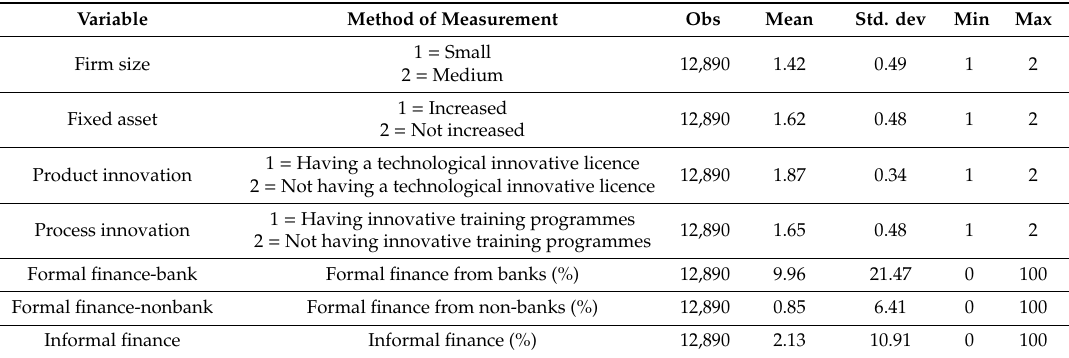
Table 2. Descriptive statistics for all countries.